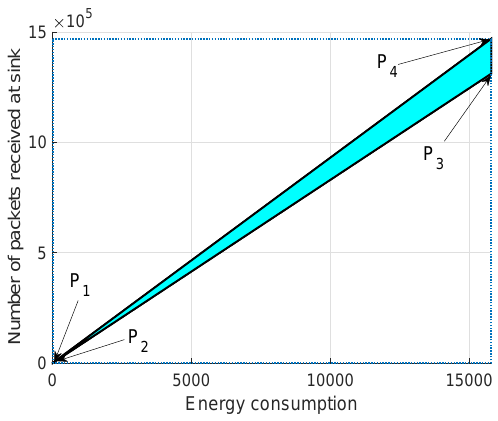
Figure 15. Feasible region for energy consumption and throughput using GEDPAR.